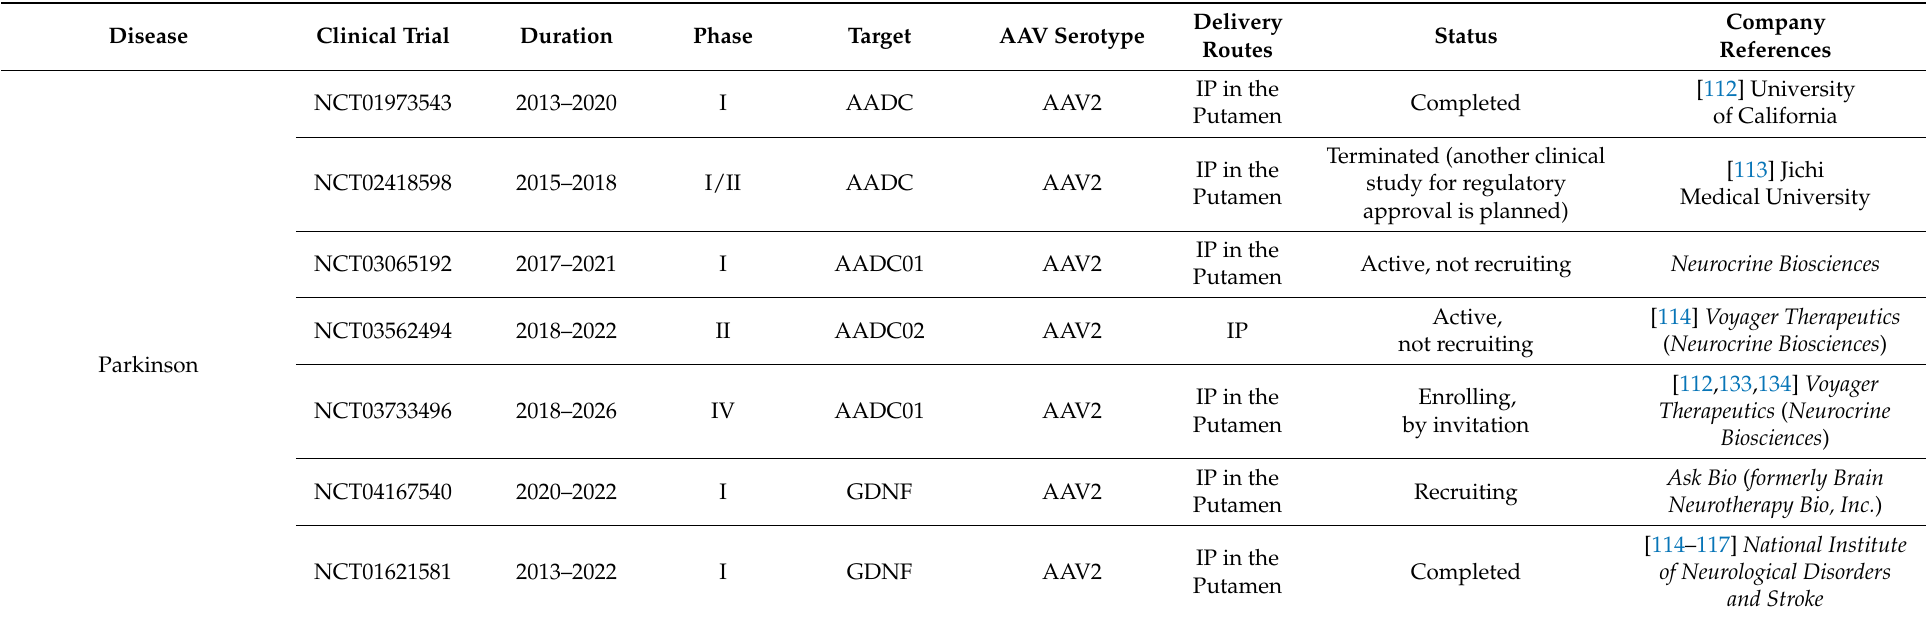
Table 2. AAV-based clinical trials for neurological disorders with AAV for PD, AD, HD, SMA and blindness related diseases. (http://www.genetherapynet.com/ clinical-trials.html; last access: 10 February 2022). Abbreviations: hTERT (active telomerase), CM (cisterna magna), STN (subthalamic nucleus), NBM (nucleus basalis of Meynert), TH (thalamus), AADC (aromatic L -amino acid decarboxylase), GDNF (glial cell-derived neurotrophic factor), GAD (glutamic acid decarboxylase), NRTN (neurturin), GBA (lysosomal enzyme glucocerebrosidase), APOE (apolipoprotein E), NGF (nerve growth factor), BDNF (brain-derived neurotrophic factor), HTT (huntingtin), RPGR (retinitis pigmentosa GTPase regulator), MCO-I (multi-characteristic opsin I), ND4 (NADH-ubiquinone oxidoreductase chain 4,